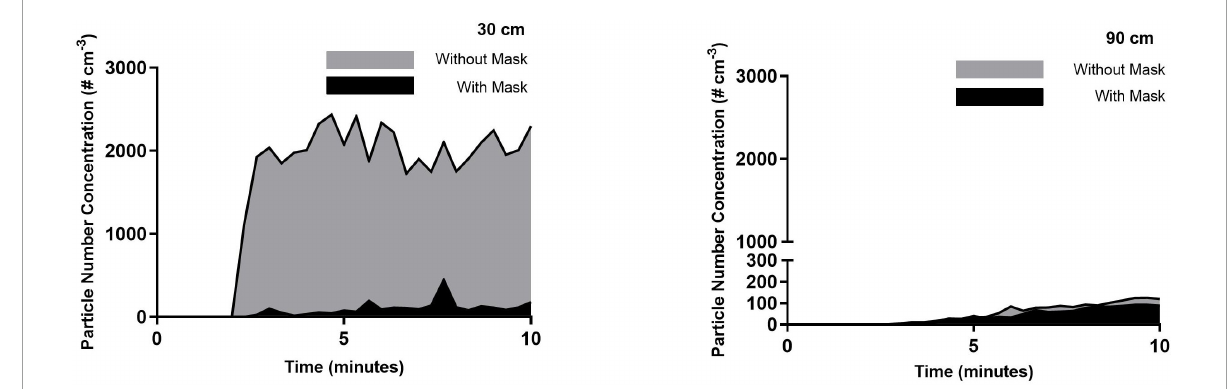
FIGURE2 Simulated exhaled aerosol with no HFNC, with and without a mask (control). Averaged time-series PNC for the three runs recorded at a distance of 30 and 90 cm from the simulated patient. Each trendline represents the data averaged across 20 s intervals.